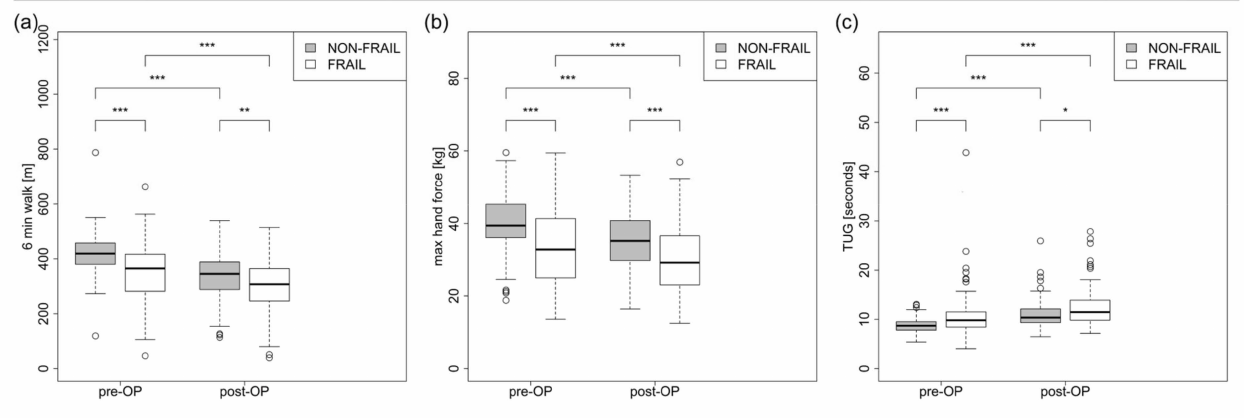
Figure 2. ( a – c ) Mobility/muscle strength tests. * p < 0.05, ** p < 0.01, and *** p <